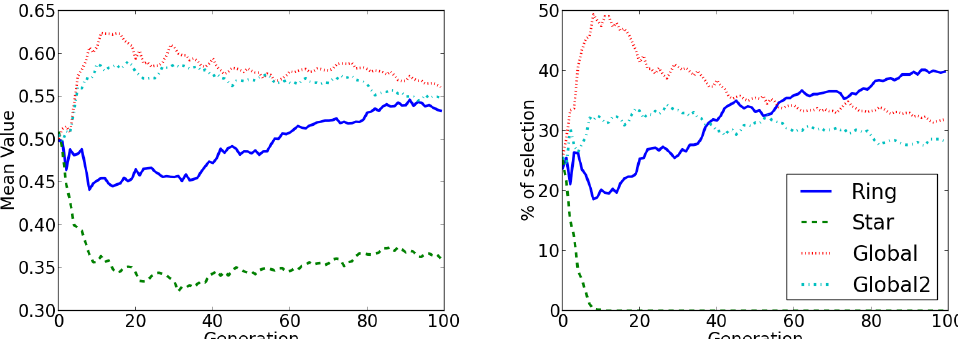
Figure A5. Average values of the genes representing the four topologies (including the replicated one) and selection percentages. The x axis reports the number of EMOPaT